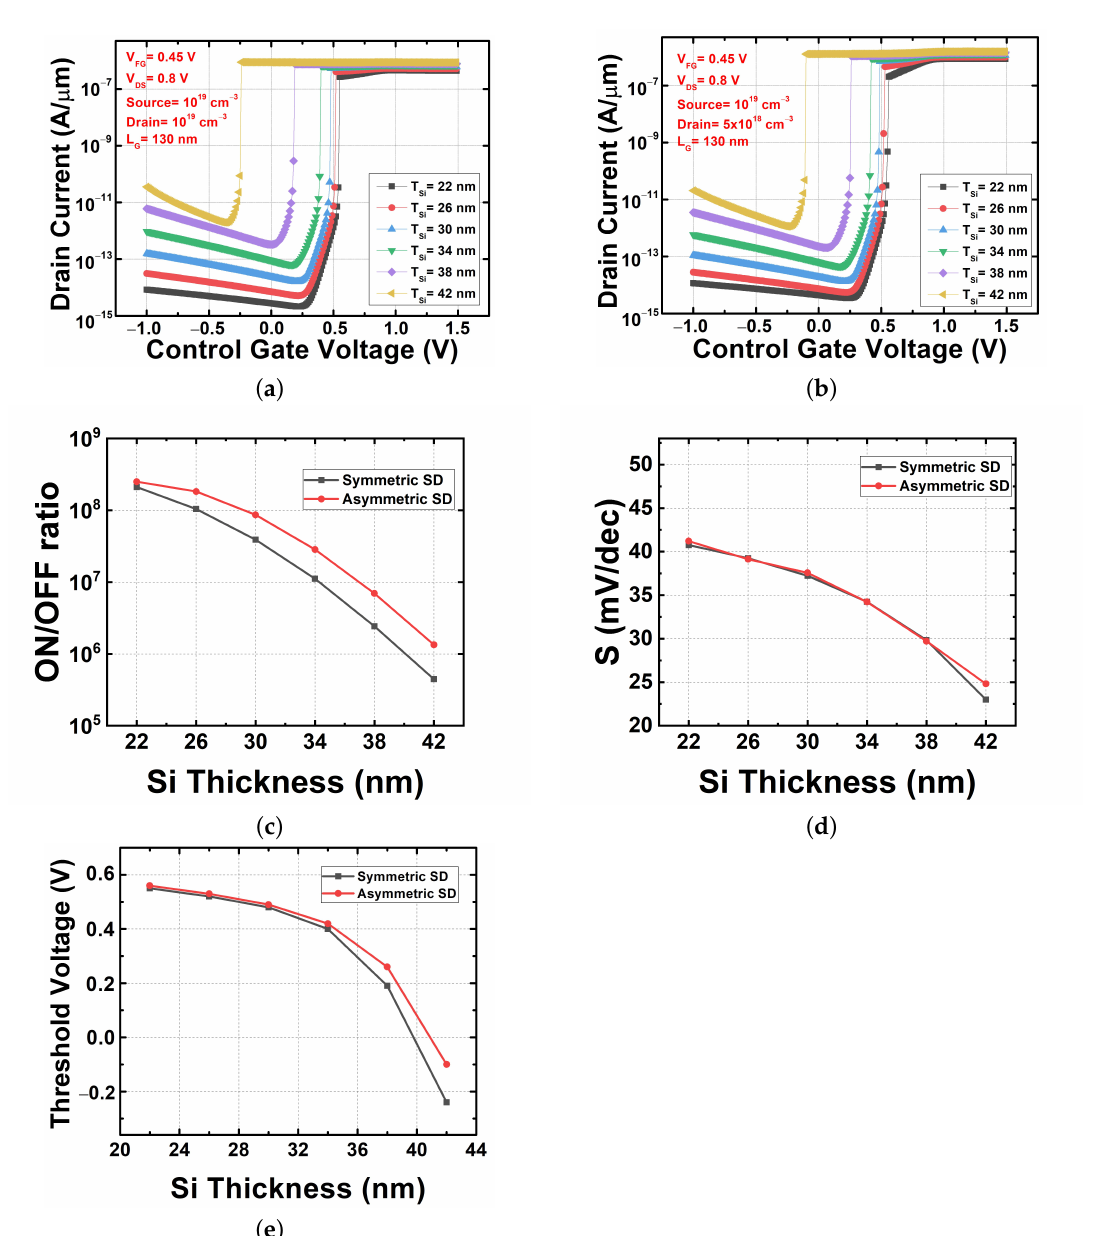
Figure 8. Electrical characteristics with channel thickness variation. ( a ) Transfer characteristics of symmetric source/drain FBFET, ( b ) transfer characteristics of asymmetric source/drain FBFET, ( c ) on–off current ratio in both FBFETs, ( d ) subthreshold swing in both FBFETs, and ( e ) threshold voltage in both